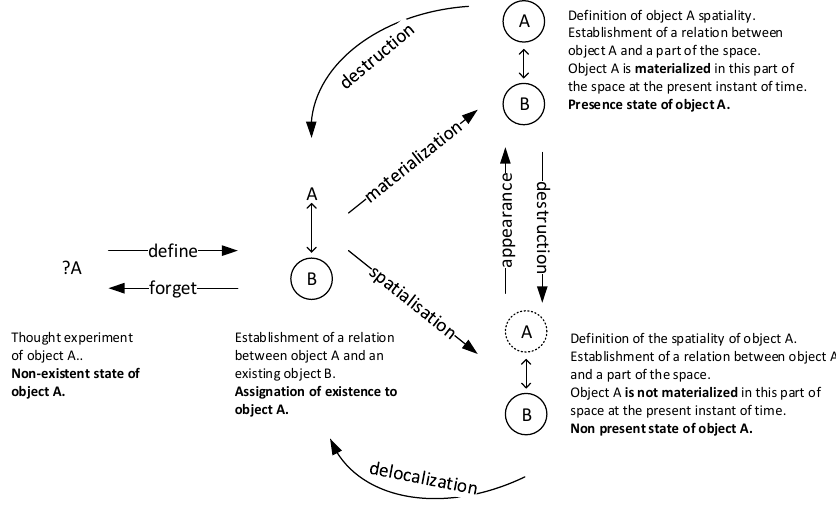
Figure 1. Conceptual schematization of the different spatio-temporal states of an object or event A. The arrows represent the transition events between these different states. The destruction corresponds to an omission of the location of the object, the delocalization marks the loss of the realization in the physical space without omission of its position.